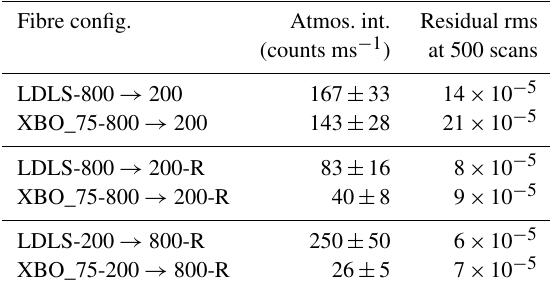
Table 5. Comparison of atmospheric measurements in Heidelberg utilizing the LDLS with different fibre configurations with and with- out roughening (marked with “ R ”) against the benchmark light source XBO_75 for the HD setup. The number combination in the setup indicates the fibre diameter on the light source end (first num- ber) and spectrometer end (second number). The 800µm fibre is always coupled to a ring of six 200µm fibres. The 500 scans cover different averaging times due to different intensities for the config- urations but thus contain a similar amount of recorded photons. Er- rors of the atmospheric intensities reflect variations through align- ment and atmospheric conditions. Fibre config. Atmos. int.